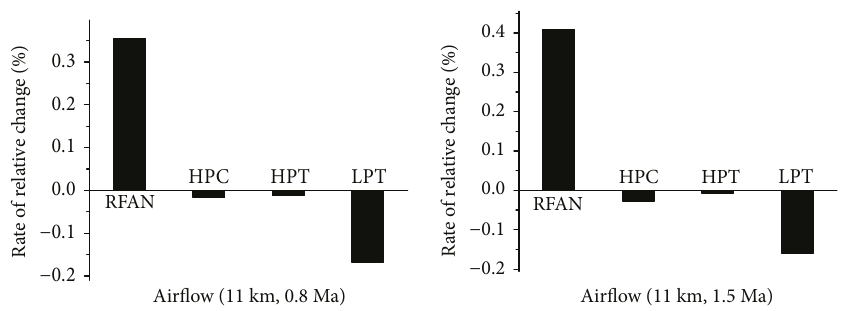
Figure 7: Sensitivity analysis of variable geometries on air fl ow (part 1).